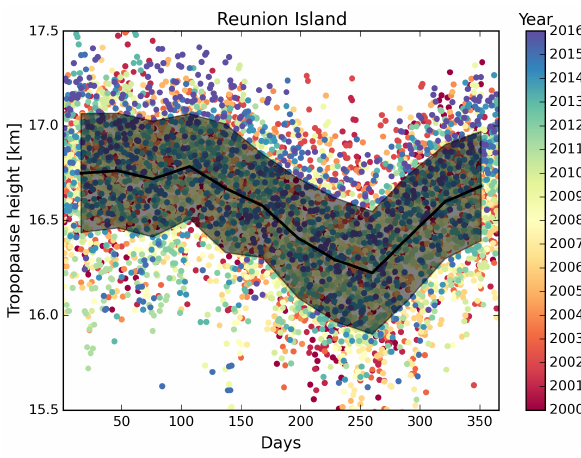
Figure 10. The tropopause height monthly means along with their uncertainties (shadow, 1 σ ) from the NCEP reanalysis data for the 2000–2016 period above Reunion